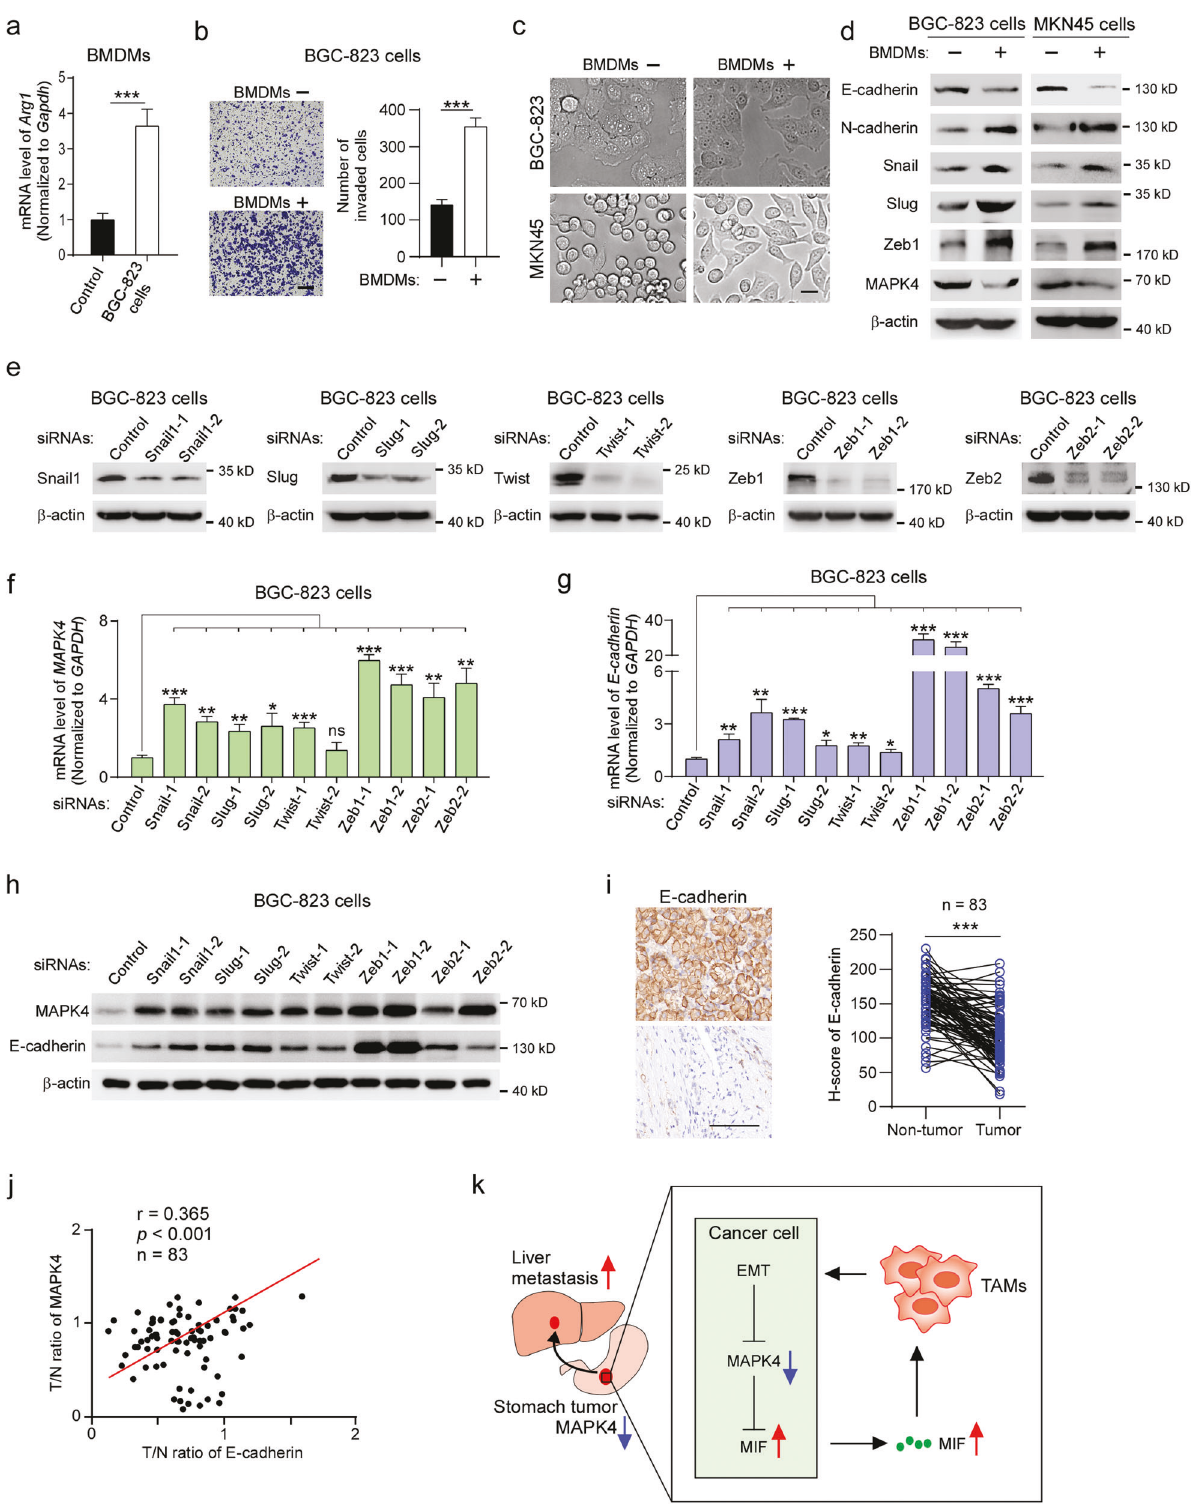
understood. Here, we provide evidence showing that MAPK4 downregulation mediates a previously unrecognized positive feedback loop between cancer cells and TAMs in gastric cancer, which constitutes a “ vicious cycle ” to drive gastric cancer liver